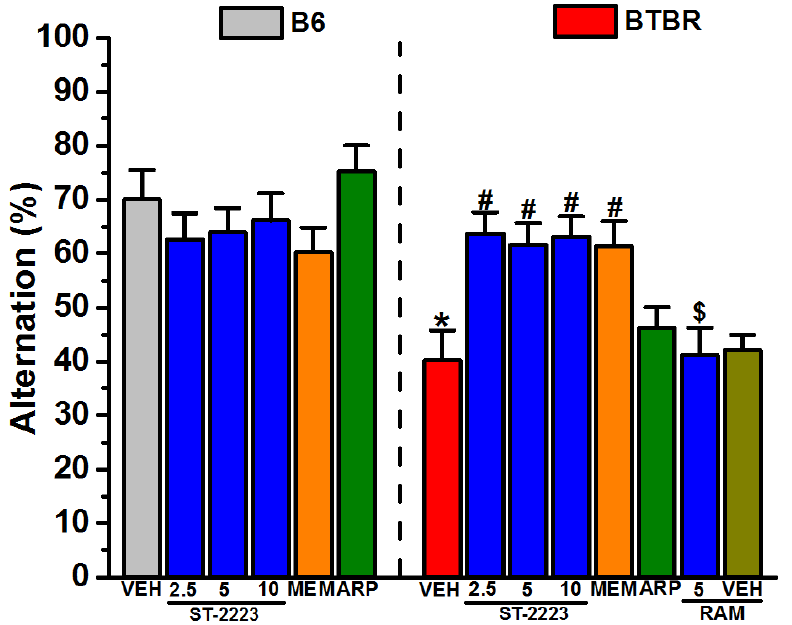
Figure 4. ST-2223 treatment enhances spontaneous alternation behavior in BTBR mice. Spontaneous alternation behavior was measured in B6 and BTBR mice. Each mouse received an i.p. injection of vehicle, ST-2223 (2.5, 5.0, or 10 mg/kg, i.p.), MEM (5 mg/kg, i.p.), or ARP (1 mg/kg, i.p.) 30–45 min prior to assessment of alternation behavior. BTBR mice demonstrated a significantly reduced percentage of spontaneous alternation behavior compared to that of B6 mice. Vehicle, ST- 2223, MEM, or ARP treatment did not affect spontaneous alternation behavior in B6 mice. ST-2223 (2.5, 5 and 10 mg/kg, i.p.) and MEM (5 mg/kg, i.p.) significantly mitigated the decreased alteration behavior in BTBR mice. ARP (1 mg/kg, i.p.) failed to alter the decreased alternation behavior of BTBR mice. The effects of systemic co-injection of RAM (10 mg/kg, i.p.) on the ST-2223 (5 mg)-induced enhancement of the alternation behavior of BTBR mice were also assessed. Data are expressed as the mean ± SEM percentage of spontaneous alternation ( n = 5). * p < 0.05 vs. vehicle-treated B6 mice. # p < 0.05 vs. vehicle-treated BTBR mice. $ p < 0.05 vs. ST-2223 (5 mg)-treated BTBR mice.